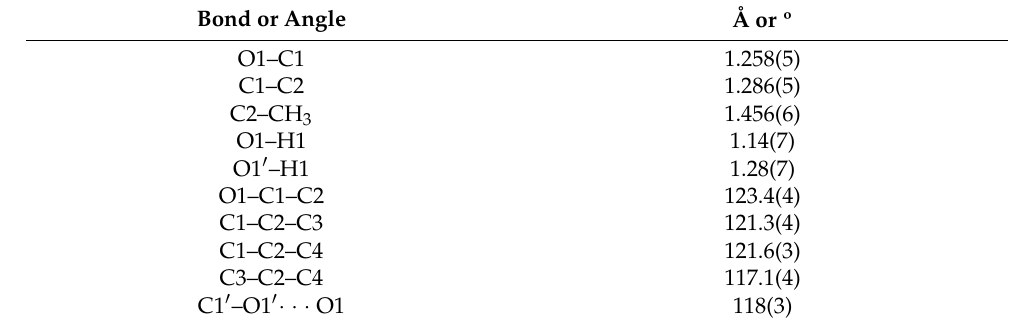
Figure 3. Schematic representation of the structures of the studied carbocation compounds. Table 1. Selected geometric parameters of proton disolvate Ia (averaged from two solvate molecules (CH 3 ) 2 C=CHOH) according to X-ray data .